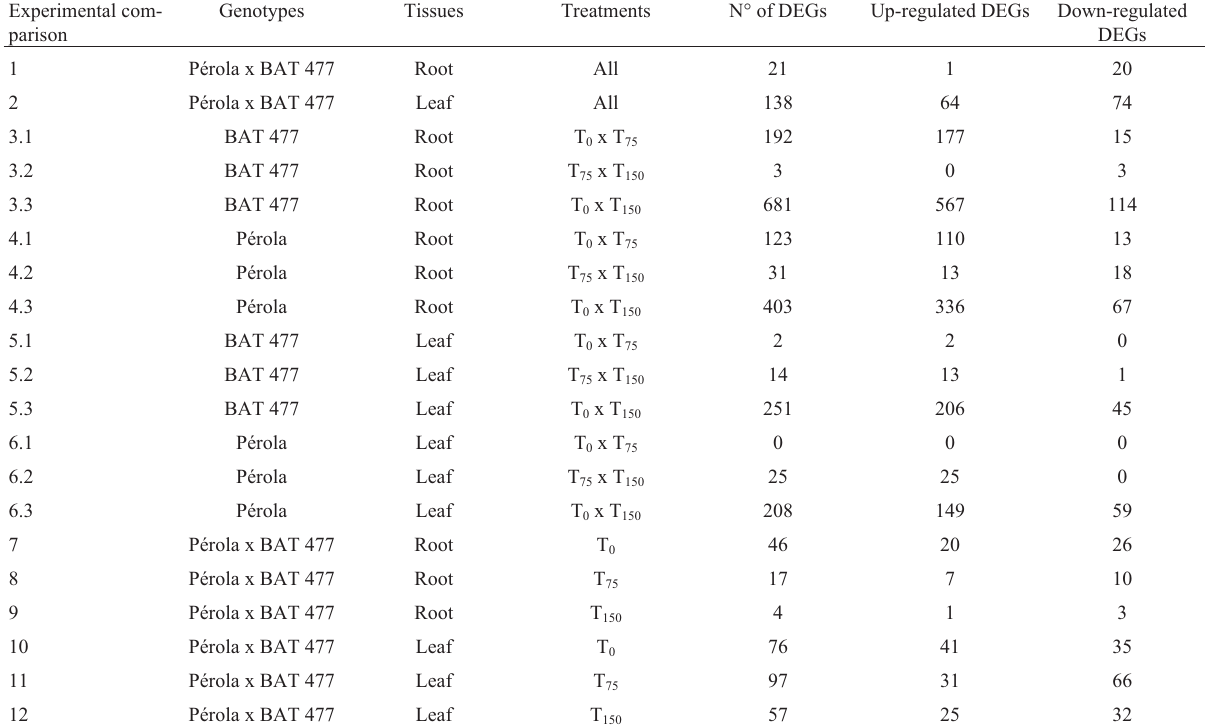
Table 1 - DEGs identified in a pairwise comparison among genotypes, plant tissues and treatments across the 12 RNA-Seq libraries. Experimental com-